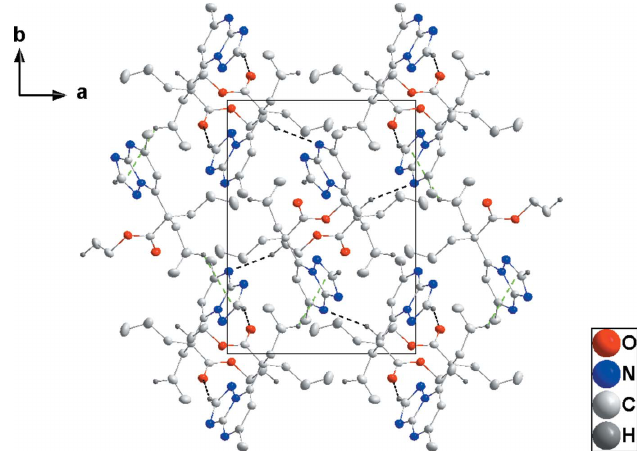
Figure 3 The packing of the title compound, viewed along the c -axis direction, with intermolecular interactions depicted as in Fig. 2.